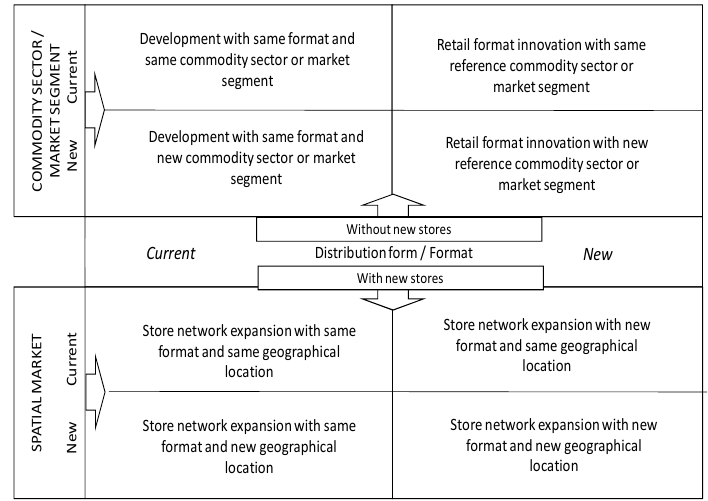
Figure 1: The Main Development Policies in Large-Scale